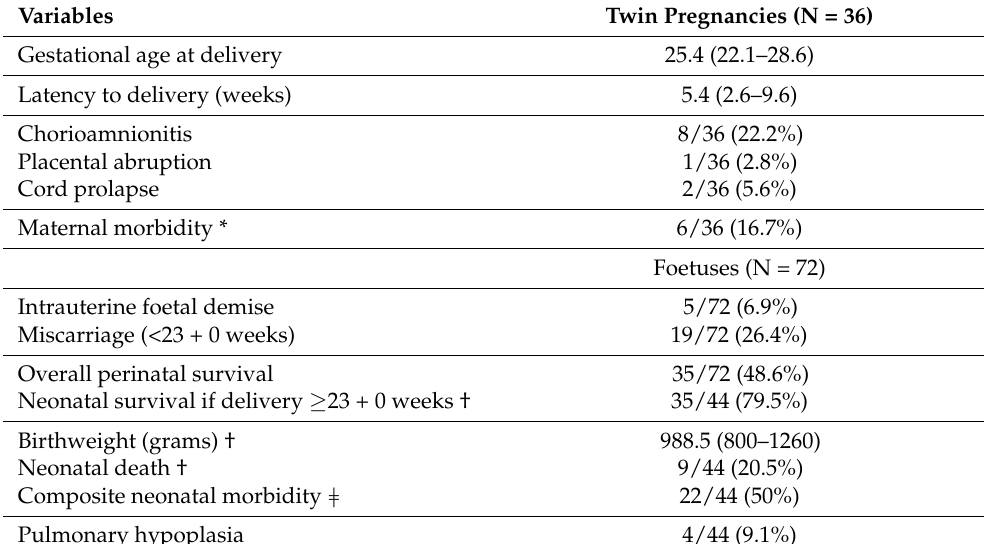
Table 2. Perinatal and maternal outcomes of previable PPROM in twins.